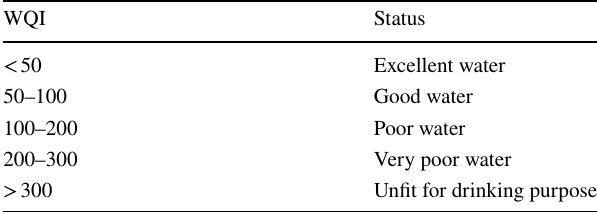
Table 2 Classification of WQI range and category of